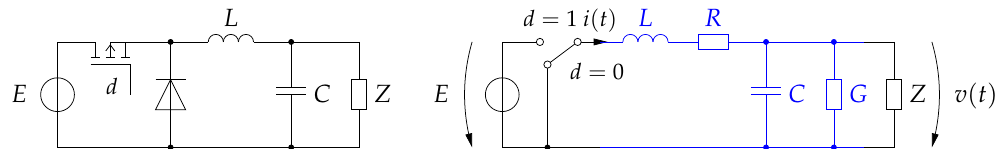
Figure 1. Classical buck converter: circuit diagram ( left ), network model ( right ), where the passive part is drawn in blue